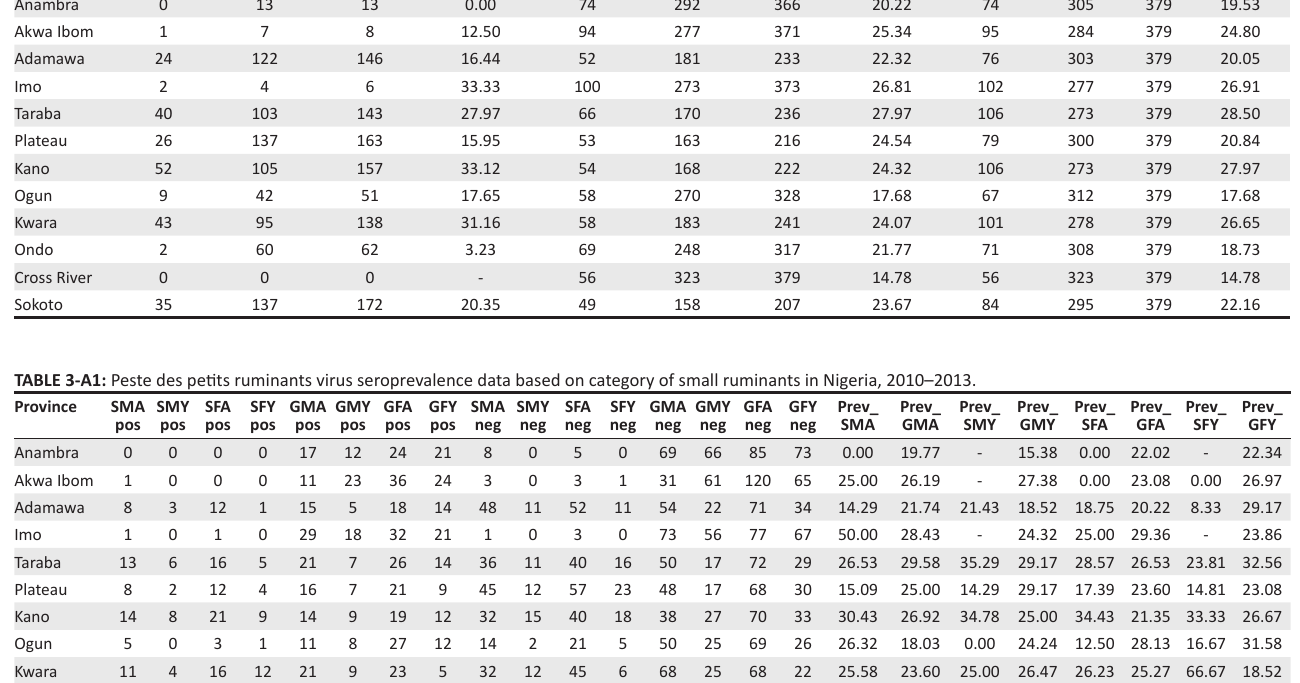
TABLE 2-A1: Nigerian individual state peste des petits ruminants virus seroprevalence data based on species of small ruminants, 2010–2013. Province SheepPos